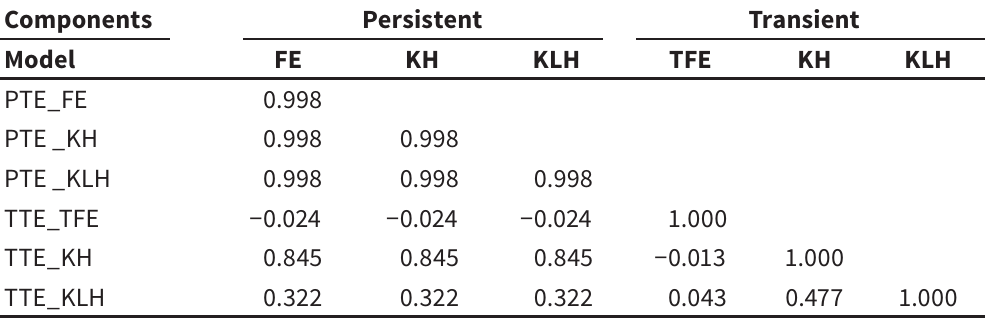
Kendall’s rank order correlation between different models Components Persistent Transient